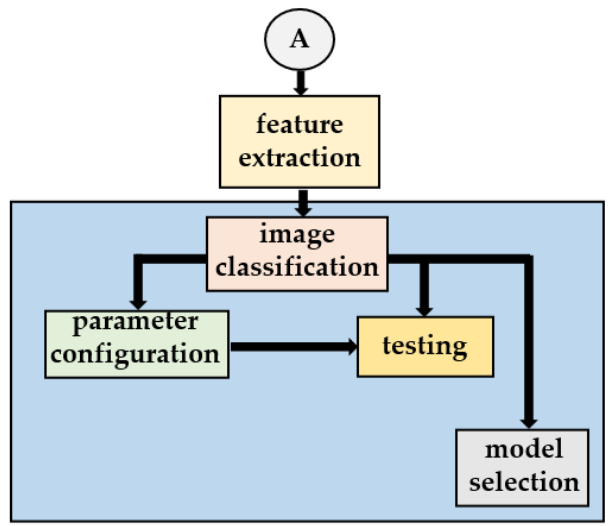
Figure 6. Proposed processing blocks of the neural network. Below are the details of each processing block and the MATLAB syntaxes used in this study. Step 1: Loading and Reading of